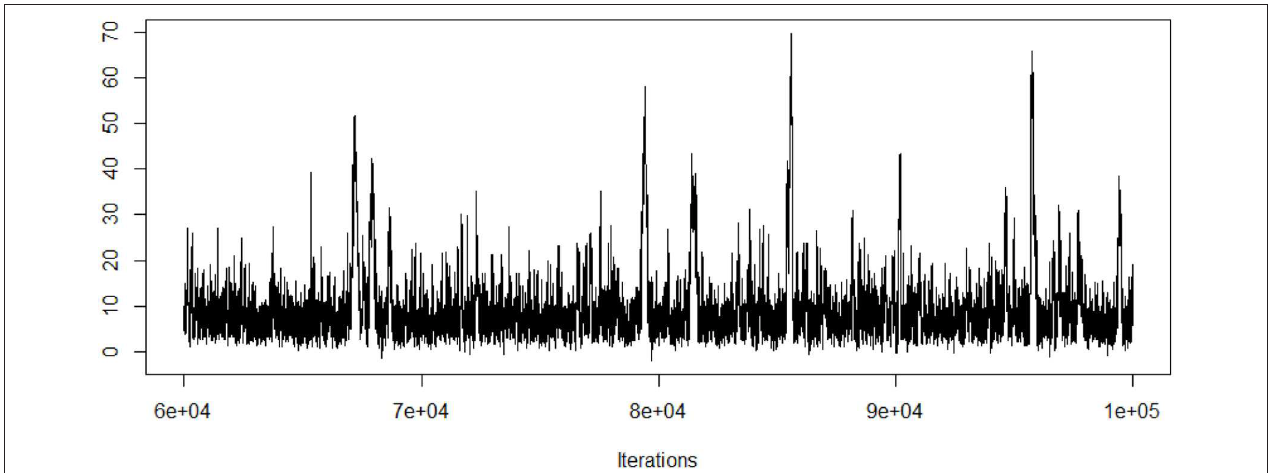
FIGURE 1 | Traceplot of the LATE estimate.